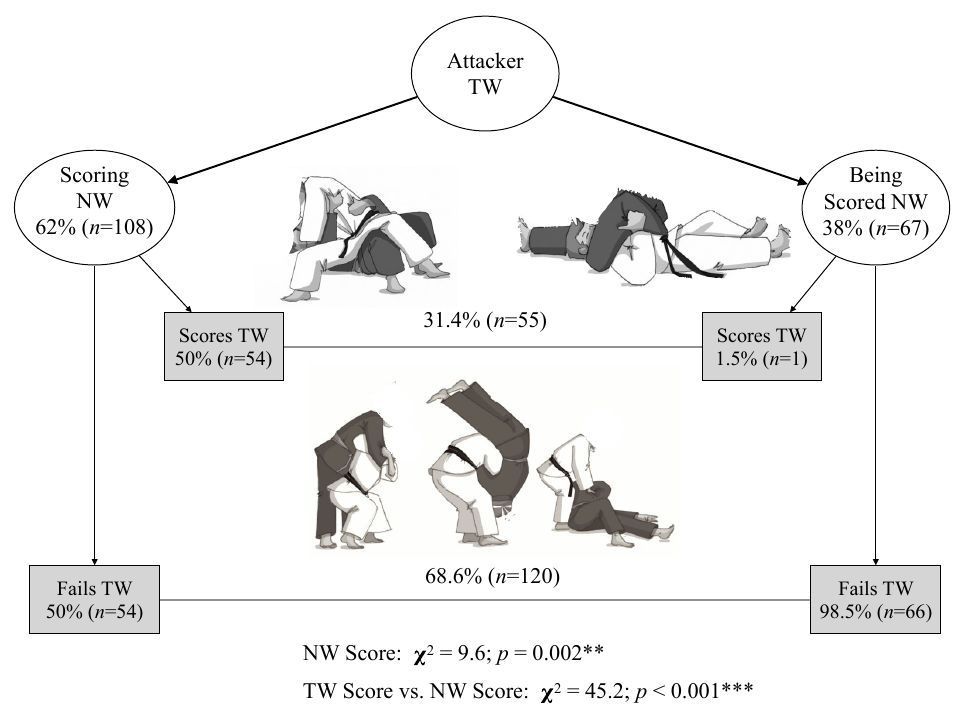
Figure 2. Attacking role in tachi-waza (TW) and the relationship between scoring in ne-waza (NW) and scoring in TW. Significant differences: ** p < 0.01; *** p < 0.001.